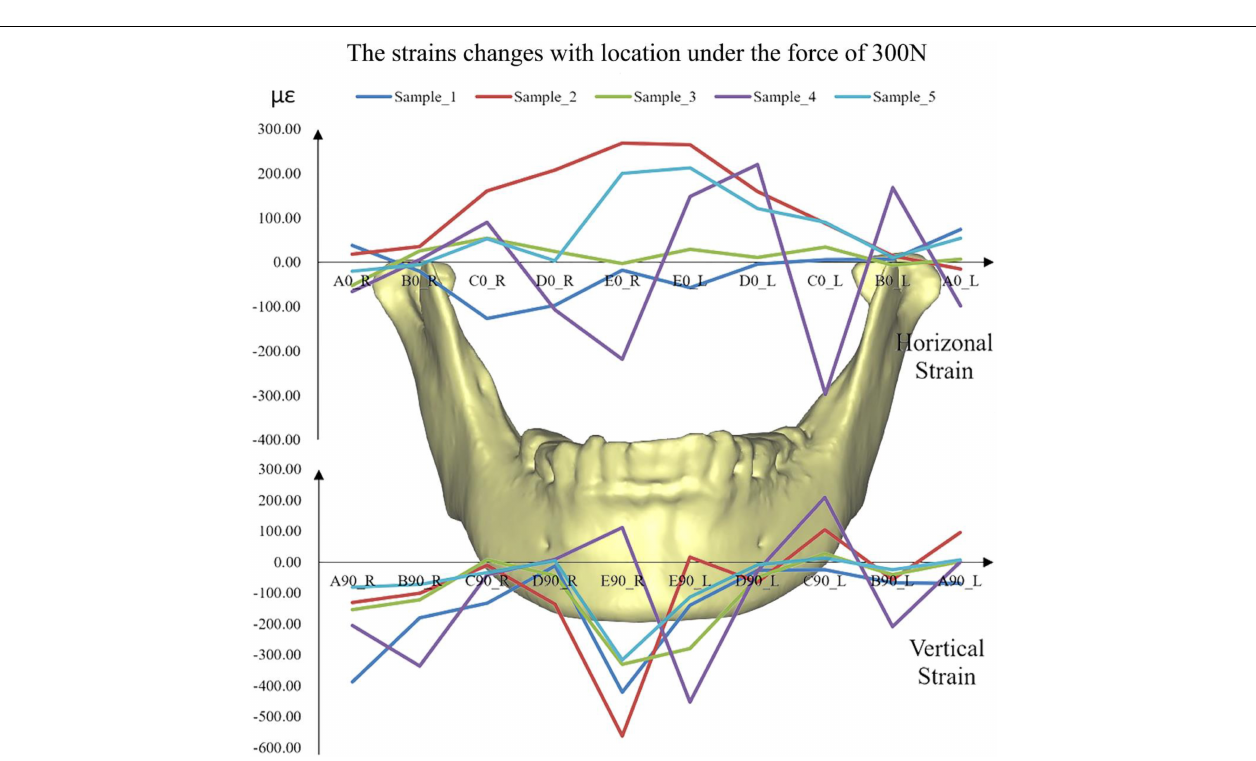
FIGURE 5 | The experimental horizontal (A) and vertical (B) strains of the 10 monitoring points with increased loads for a single sample. A located at the bilateral mandibular condyle necks, B located at the bilateral mandibular angles, and C, D, and E located at the bilateral mandibular bodies. 0 and 90 represented the horizontal and vertical directions, respectively. R and L represented the right and left sides, respectively.